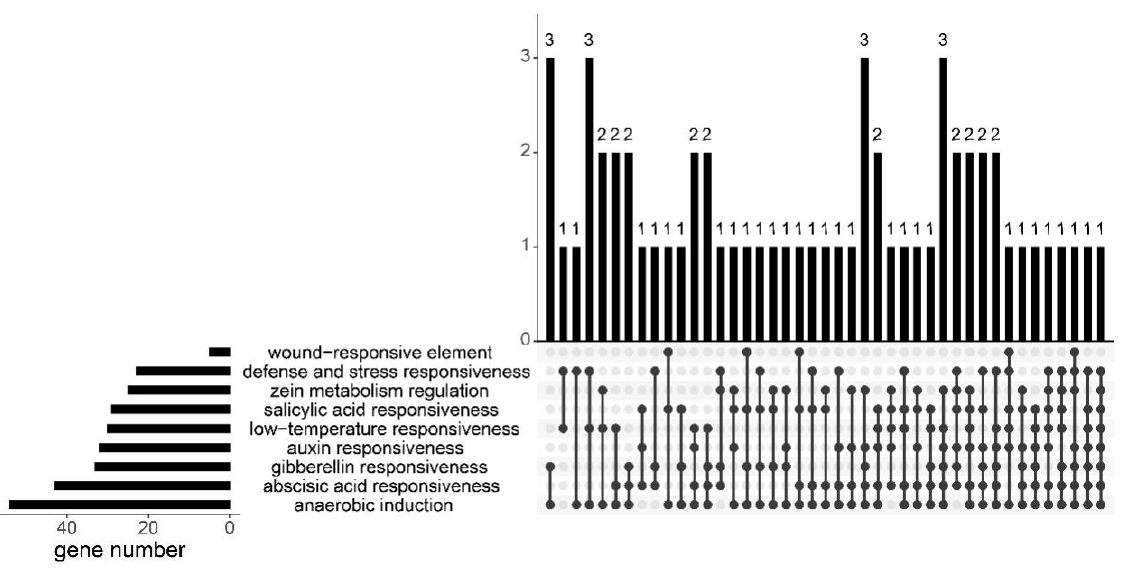
Figure 5. Distributions of cis-acting elements in promoters of Brassica GYFs and AtGYFs . The UpSet plot shows the distribution of cis-acting elements in GYFs promoters. The bar chart above represents the number of genes contained in each type of GYFs . The bar chart at the bottom left represents the number of genes included in each type of cis-acting element. The dotted line shows the types of cis-acting elements contained in the group.